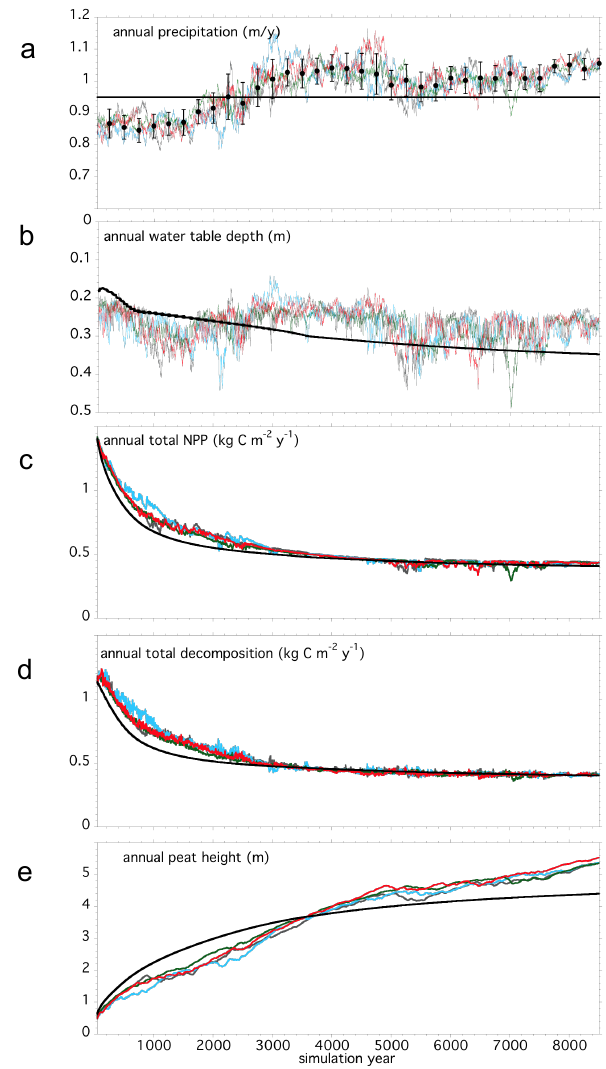
Fig. 4. (a) Four manifestations of annual precipitation (my − 1 ) with amplitude of random variability α =2.5 and persistence φ =0.99 (see Eqs. 19–20). Solid black circles are regional mean annual pre- cipitation at 250-year intervals, bars are regional variance, as deter- mined by Muller et al. (2003b); solid black line represents constant mean annual precipitation. (b) HPM simulated annual water table depth (m below peat surface) for 4 random precipitation drivers and constant precipitation (solid black line). (c) Simulated annual total NPP for 4 random precipitation drivers and constant precipitation (solid black line). (d) Simulated annual total decomposition for 4 random precipitation drivers and constant precipitation (solid black line). (e) Simulated annual peat height for 4 random precipitation drivers and constant precipitation (solid black line). NOTE: all pan- els start with simulation year 50, avoiding the peatland initialization period (see